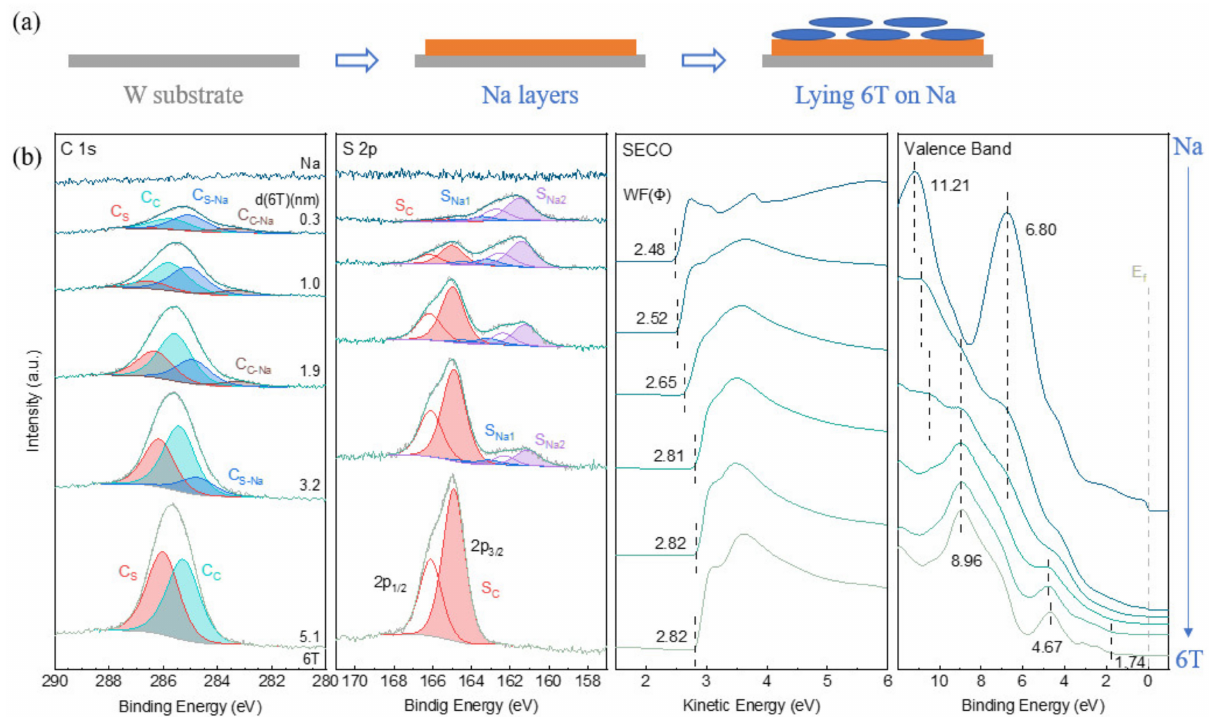
Figure 3. ( a ) Schematic of the 6T molecules and Na atoms deposition sequences. ( b ) XPS and UPS spectra of Na films with stepwise 6T deposition on a tungsten